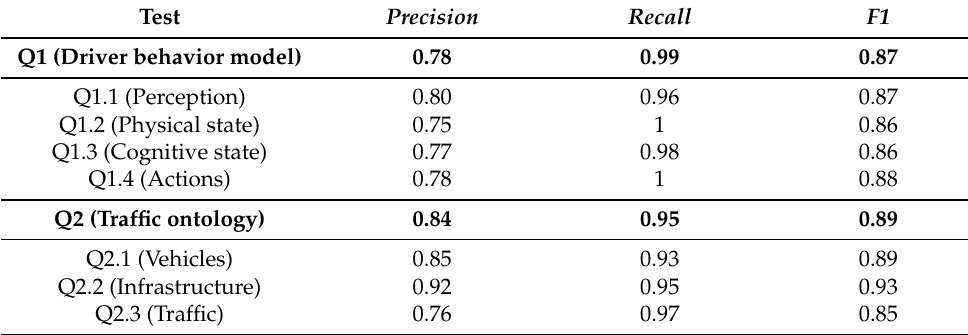
Table 4. Experimental results. Knowledge base. Expressiveness validation. Test Precision Recall